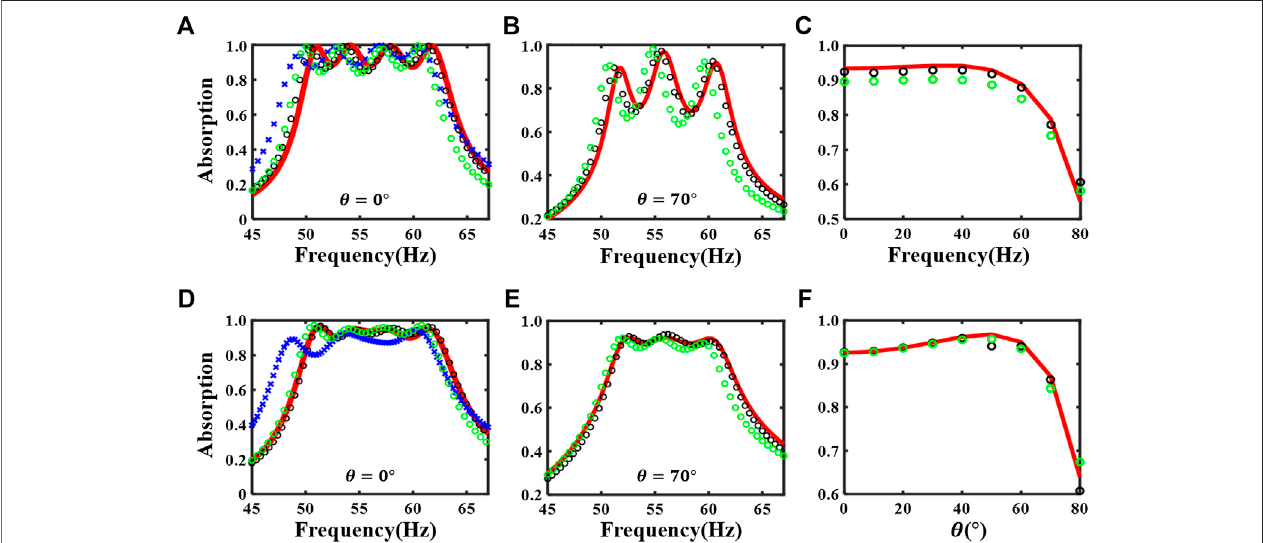
FIGURE 6 | (A) The theoretical (red solid line), the fi rst type of numerical (black circles), the second type of numerical (green circles) and experimental (blue cross) absorptioncoef fi cientatnormalincidence. (B) Thetheoreticalandthetwotypesofnumericalabsorptioncoef fi cientfortheangleofincidence70 ° . (C) Thetheoreticaland the two types of numerical average absorption coef fi cient over 50 – 63 Hz vs. angle of incidence. (A-C) and (D-F) are for the non-optimized and the optimized metasurface absorber, respectively.